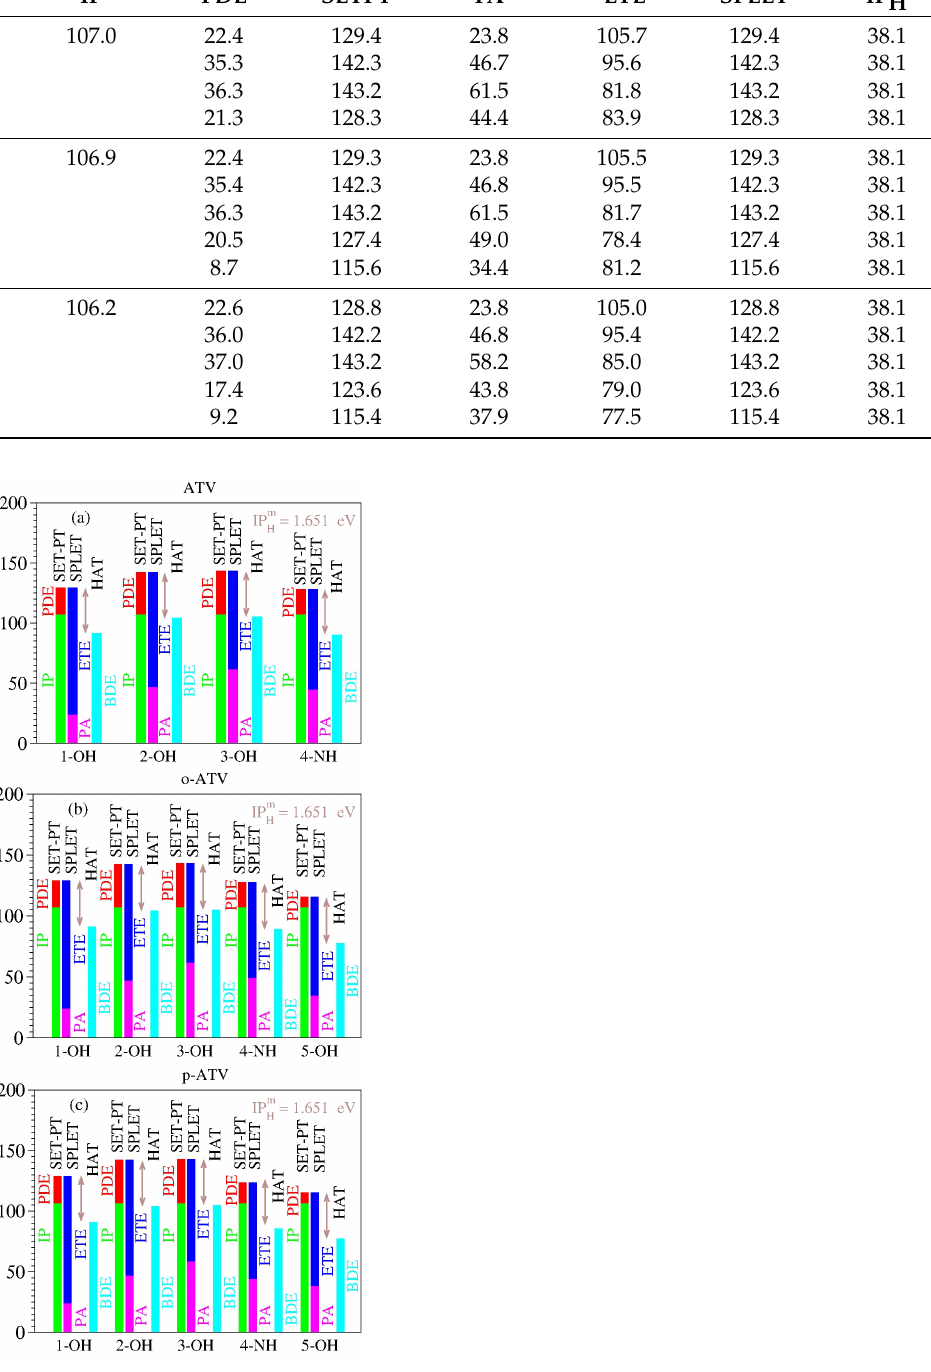
Figure 1. The enthalpies of reaction for ( a ) atorvastatin (ATV) and its ( b ) ortho-hydroxy (o-ATV) and ( c ) para-hydroxy (p-ATV) metabolites [22] satisfy the two theorems of antioxidation discussed in this paper. See the main text for